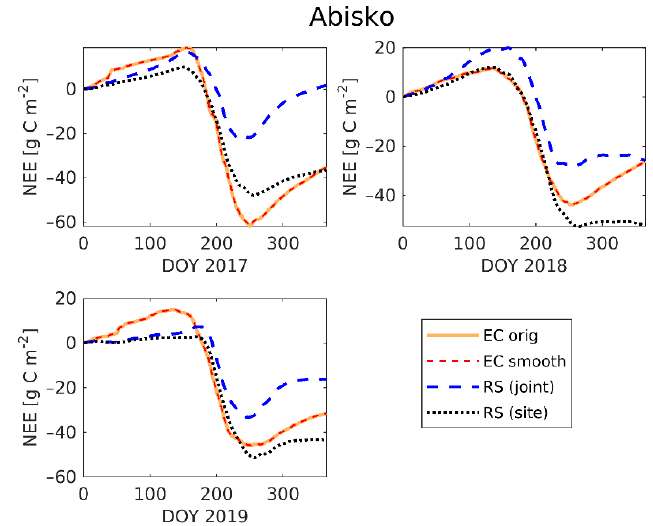
Figure 7. Time series of cumulative NEE for Abisko-Stordalen in 2017, 2018, and 2019 for the original EC measured NEE (EC orig), the TIMESAT smoothed NEE (EC smooth), the non-linear regression model of NEE with joint parameters (RS joint), and the non-linear regression model of NEE with site-specific parameters (RS site). There is nearly complete correspondence between the original and the spline-smoothed EC data.